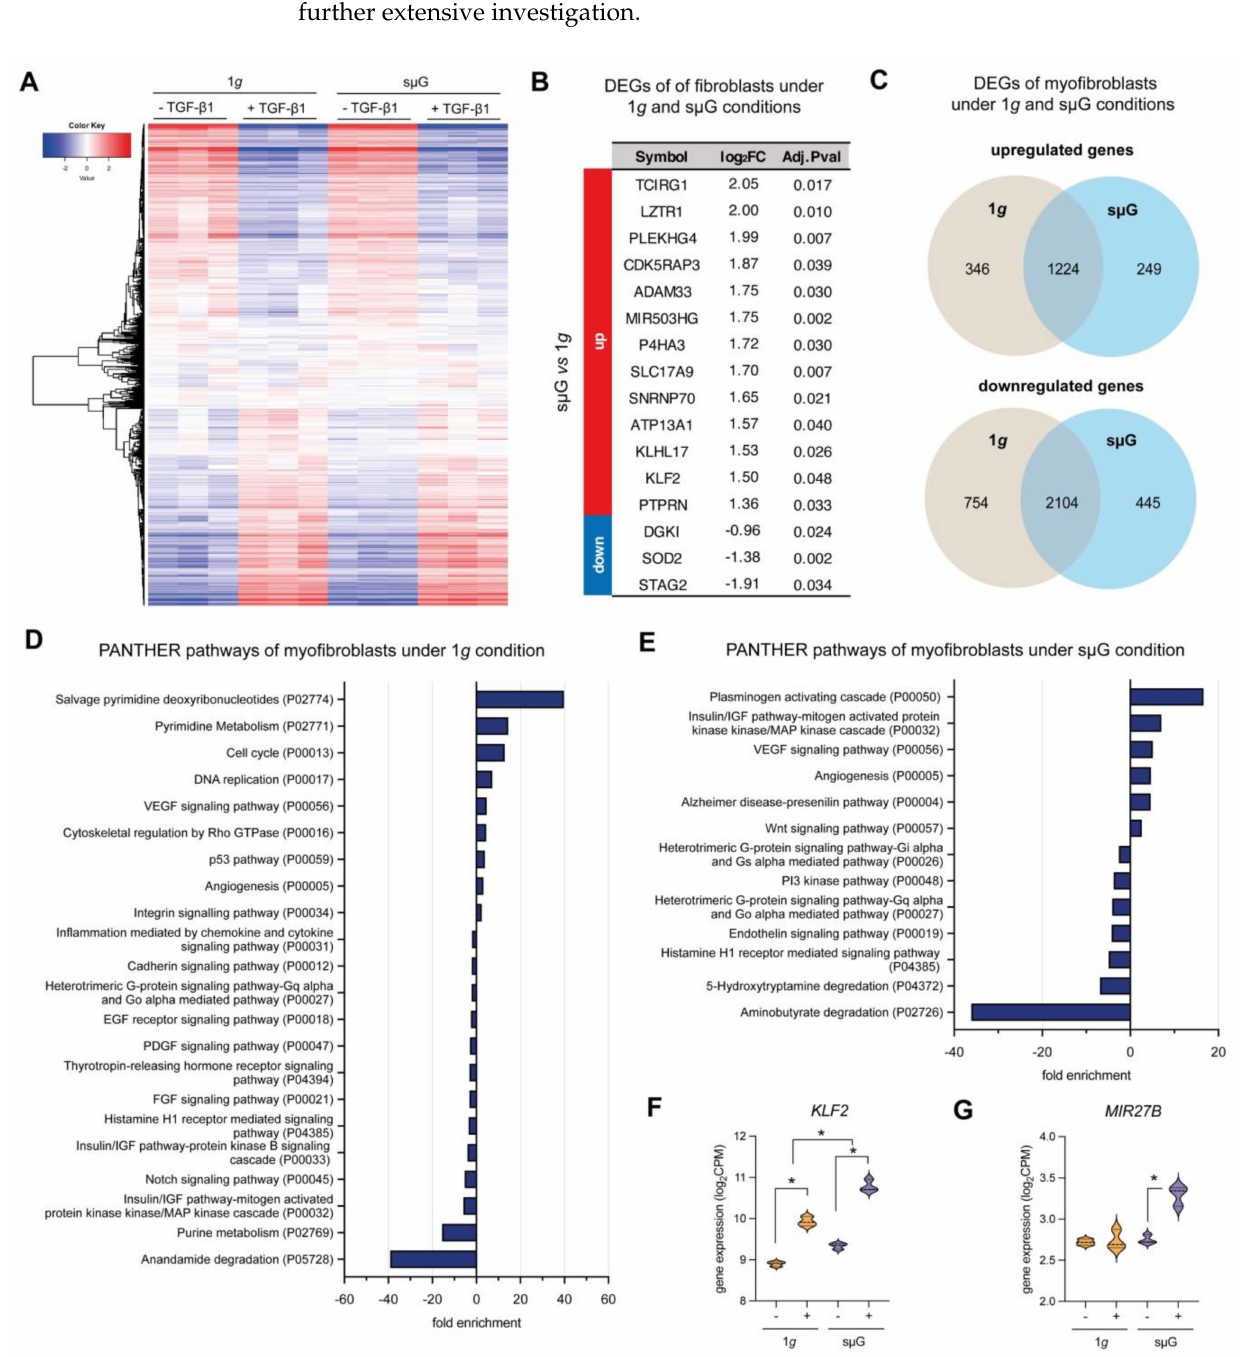
Figure 5. RNA-Sequencing analysis of fibroblast and myofibroblast under 1 g and s µ G conditions. ( A ) Heat map of overall gene expression levels in fibroblasts and myofibroblasts under 1 g and under s µ G. DEGs were analyzed using DESeq2 with FDR cutoff ≤ 0.05 and FC ≥ 2.0 using DESeq2 ( B ) Table of differentially expressed genes (DEGs) with log 2 fold change (log 2 FC) and adjusted P-value of fibroblasts cultured under 1 g and under s µ G. Up- and downregulated genes were compared between s µ G and 1 g conditions. ( C ) Venn diagram of up- and down-regulated DEGs of myofibroblast cultured under 1 g and under s µ G. The DEGs were analyzed for enriched biological pathways using statistical overrepresentation tests using the PANTHER pathway for ( D ) 1 g and ( E ) s µ G conditions. Gene expression of specific DEGs which has been reported to be involved in inhibition of fibroblast differentiation, namely ( F ) KLF2 and ( G ) MIR27B. Data are shown as a violin plot; * significance level of p < 0.05. The experiment was performed with three